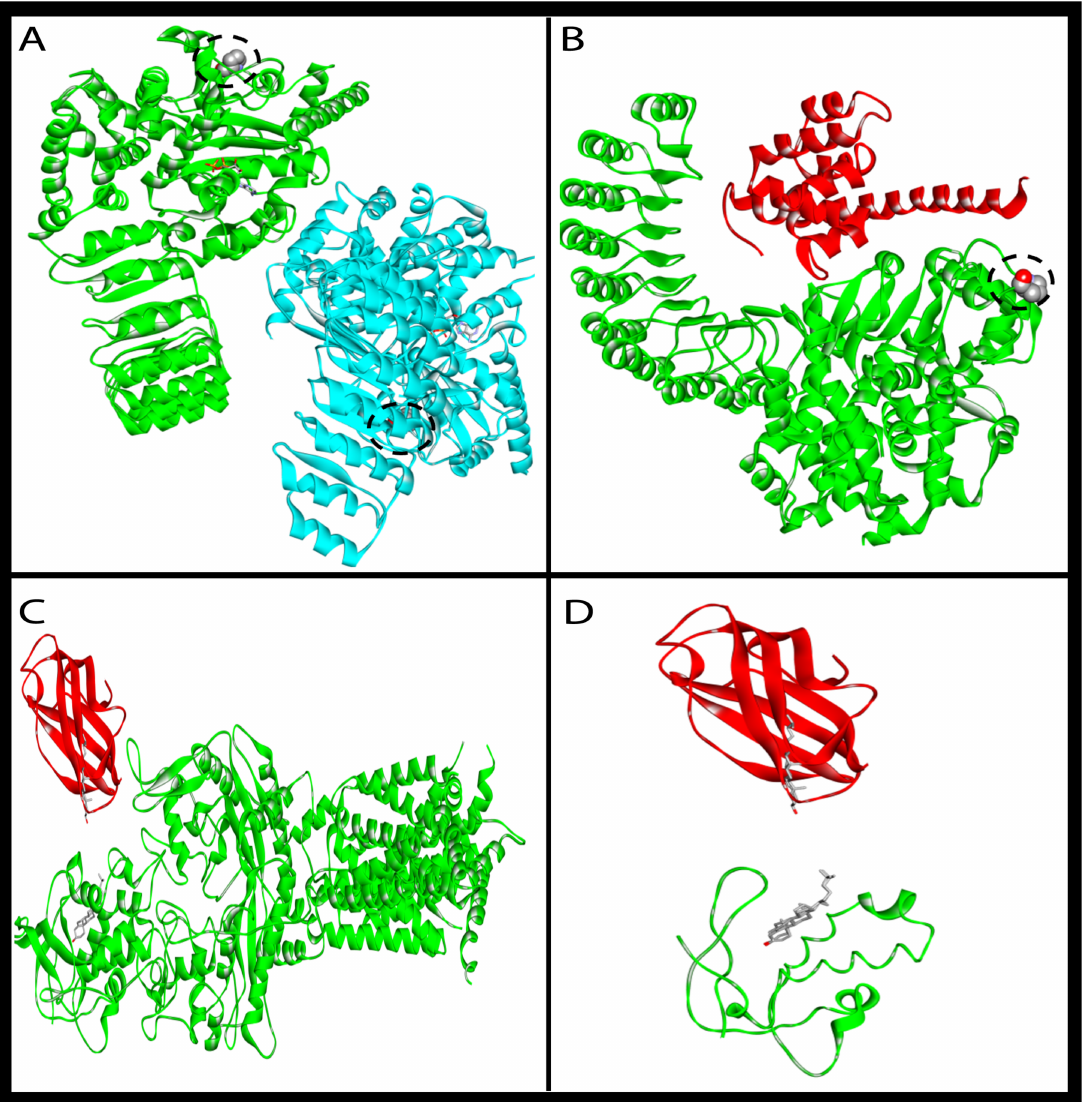
Figure 6. Mutated protein simulation analysis. Illustration of ( A ) NOD2 dimer (green and cyan colors) and ( B ) the best score docked pose of NOD2 monomer (green) and its binding partner CARD9 (red). Proline380 is denoted by space-filling spheres and is surrounded by a dotted circle; it is located far from the binding interface. The NOD2 structure was based on the PDB structure with the ID 5IRM. The variant of proline380 to leucine had no effect on the binding of the two monomers in the dimer form or on the binding with CARD9. Comparison between ( C ) wild-type NPC1 (green) and ( D ) the truncated form of NPC1, and their binding with their partner NPC2 (red). Truncated NPC1 lost its binding interface with